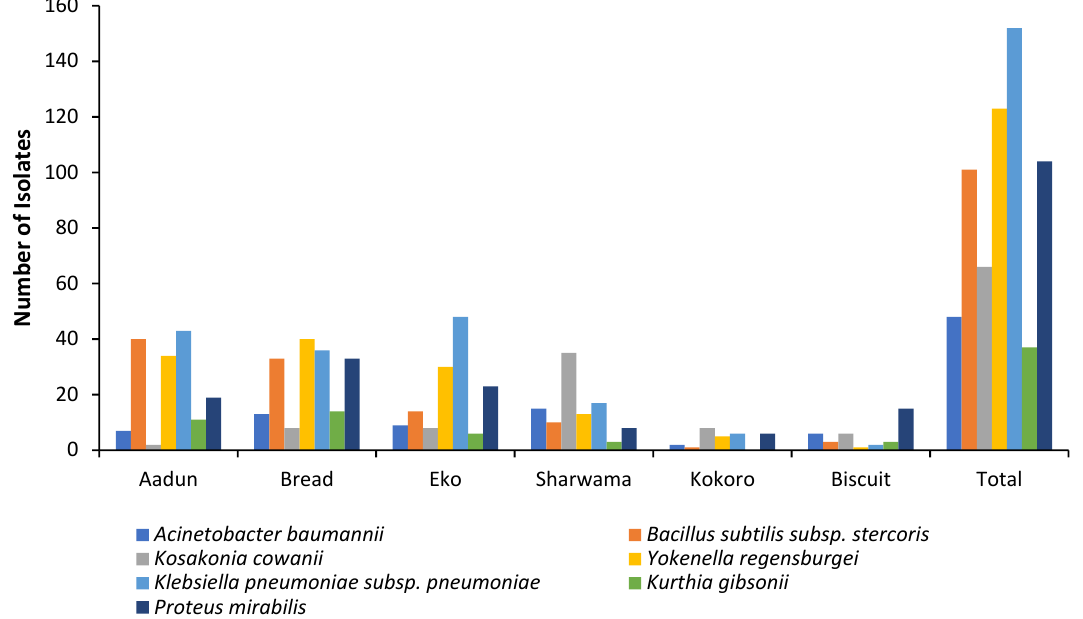
Figure 3. Distribution of 631 bacterial isolates in ready-to-eat foods vended in Lagos, Nigeria.